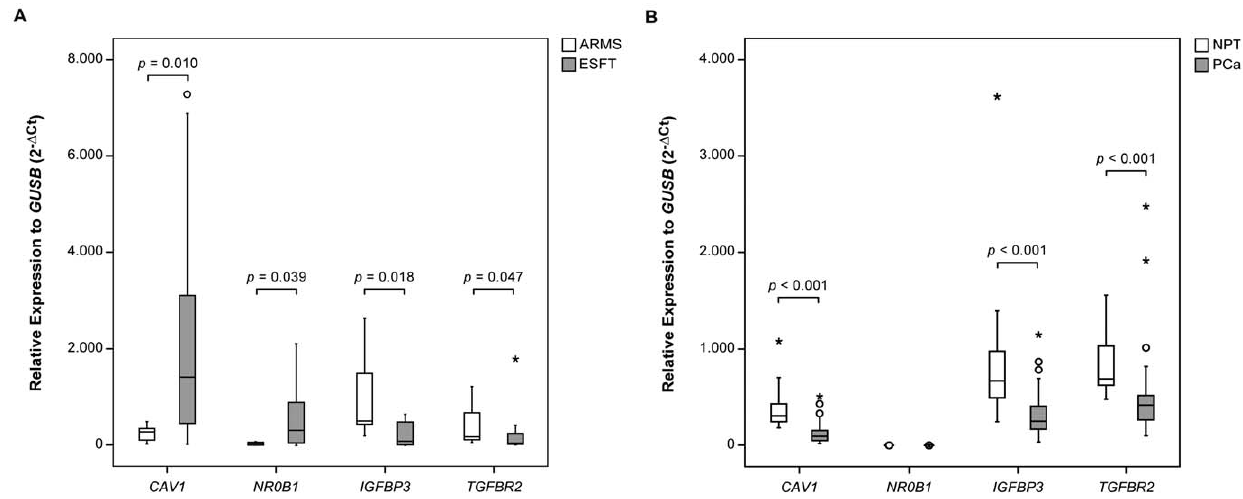
Figure 1. Box-plot representation of the qRT-PCR data for the four genes described as EWSR1-FLI1 targets ( CAV1 , NR0B1 , IGFBP3 and TGFBR2 ). A) ESFT versus ARMS samples; B) PCa versus NPT samples. A p value is shown whenever the differences in each two group comparison reach significance ( p , 0.05).